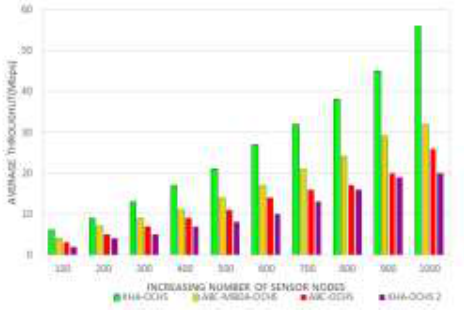
Figure 5 . Proposed NIUS-HEHOA-OCHS: Improvement in Mean Throughput under different network size